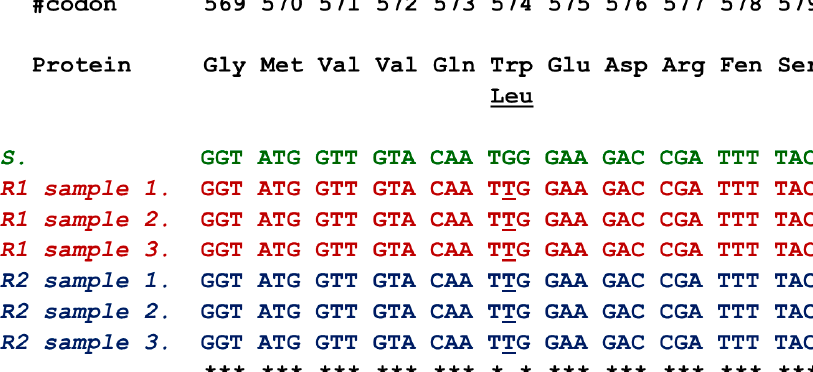
Figure 3. Acetolactate synthase ( ALS ) sequences of imazamox susceptible ( S ) and resistant ( R1 and R2 ) wild poinsettia ( Euphorbia heterophylla ). A single nucleotide change from T for G at the 574 codon (underlined letter) results in a Trp574Leu mutation in all resistant plants. R1 is also resistant to PPO-inhibiting herbicides and R2 is also resistant to glyphosate.